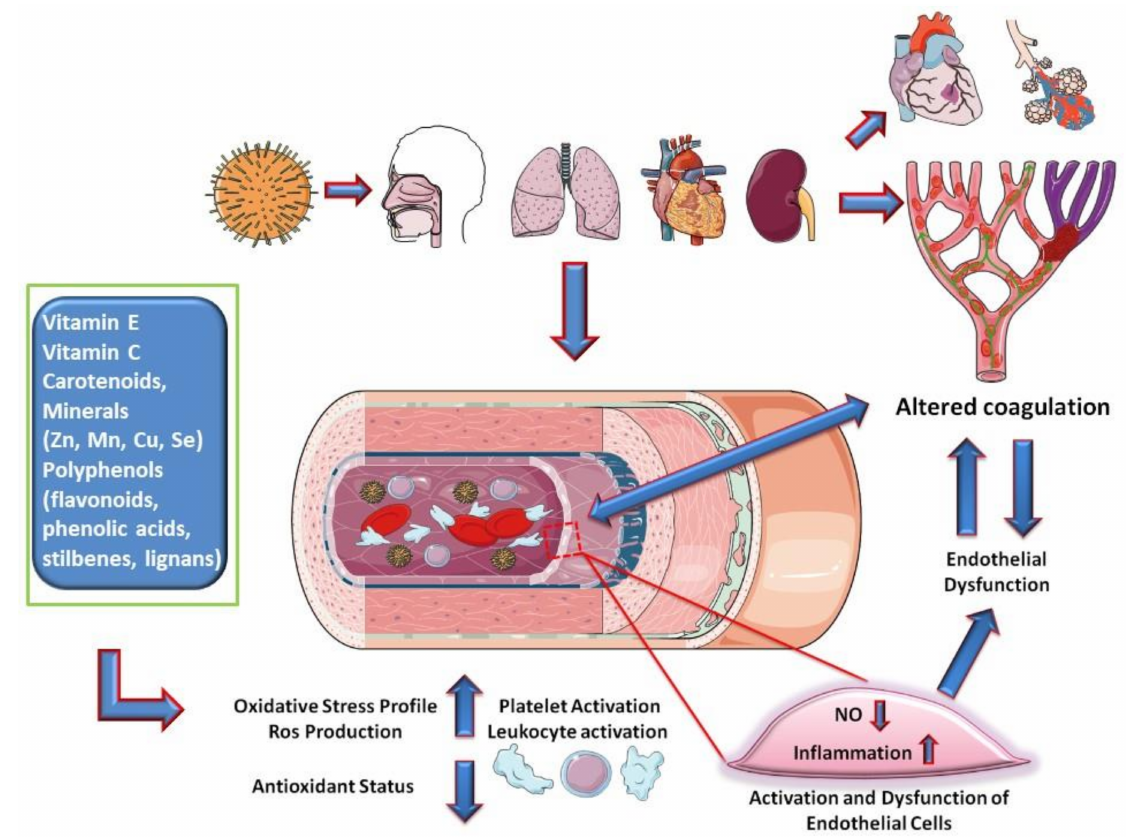
Figure 2. Hypothesis on the mechanisms of endothelial involvement in